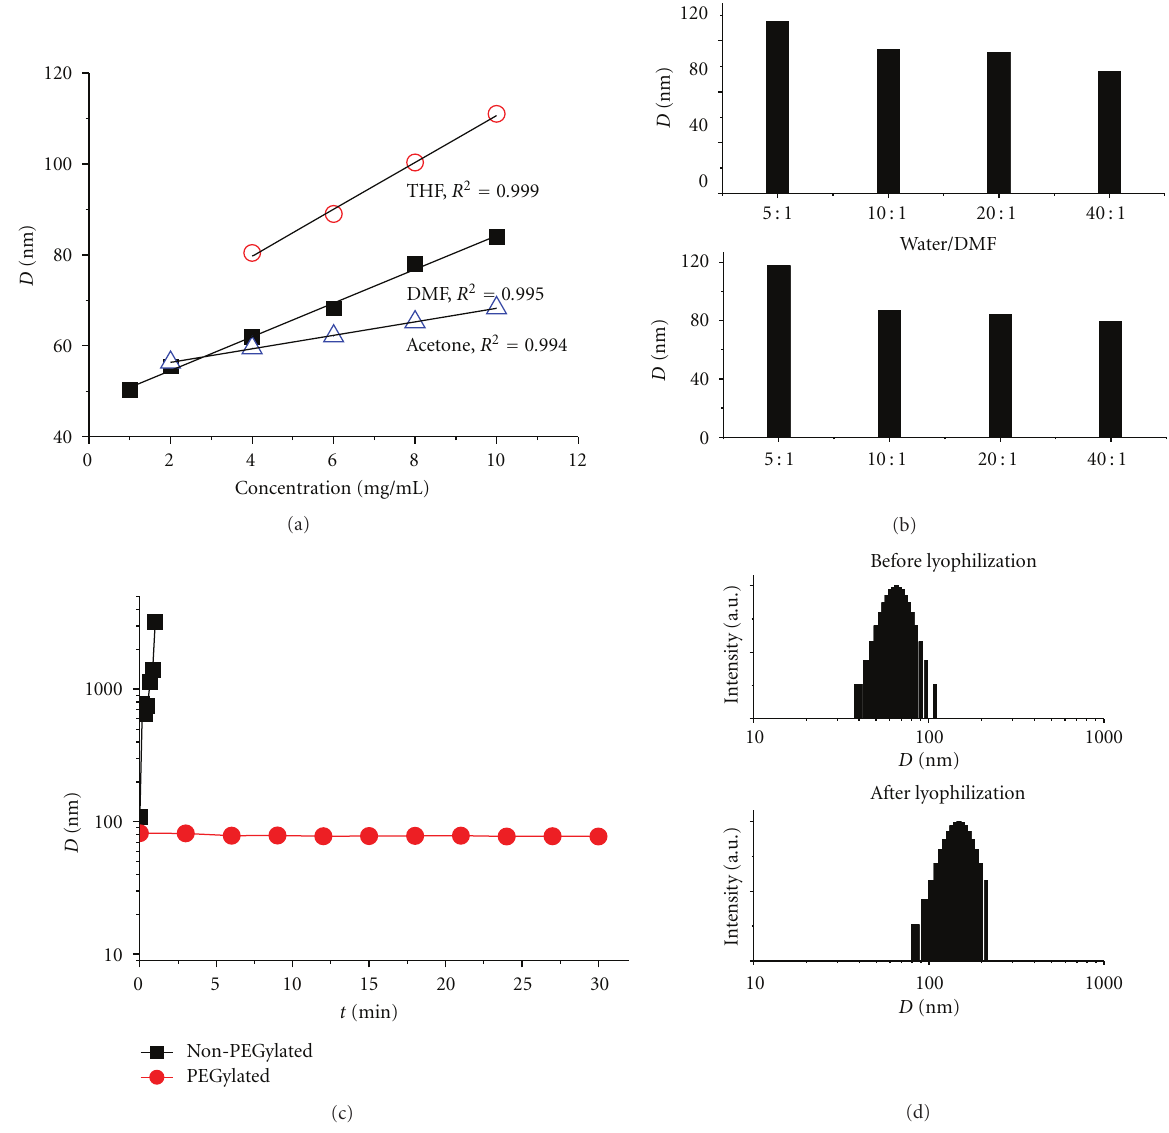
Figure 2: Controlled formulation of CsA/PEG-PLGA-NPs. Correlation of NP sizes versus polymer concentrations in di ff erent organic sol- vents at constant ratio of volume of solvent to water. NP sizes increased from 42.3 nm to 91.4 nm as the polymer concentration increased from 1mg/mL to 10 mg/mL in DMF. Similar trends were observed in acetone and THF (a). Correlation of NP sizes versus ratio of volume of solvent to water in di ff erent organic solvents at constant polymer concentrations (10mg/mL) (b). The PEGylated CsA/PEG-PLGA-NPs kept their original size and remained nonaggregated for an extended period of time. However, when the non-PEGylated NPs were tested in PBS (1 × ), they were unstable and formed large aggregates rapidly (the particle size increased from 108.1 nm to 3223.1 nm within 1min) (c). The size of NPs increased slightly but maintained a single distribution after lyophilization with BSA as the lyoprotectant